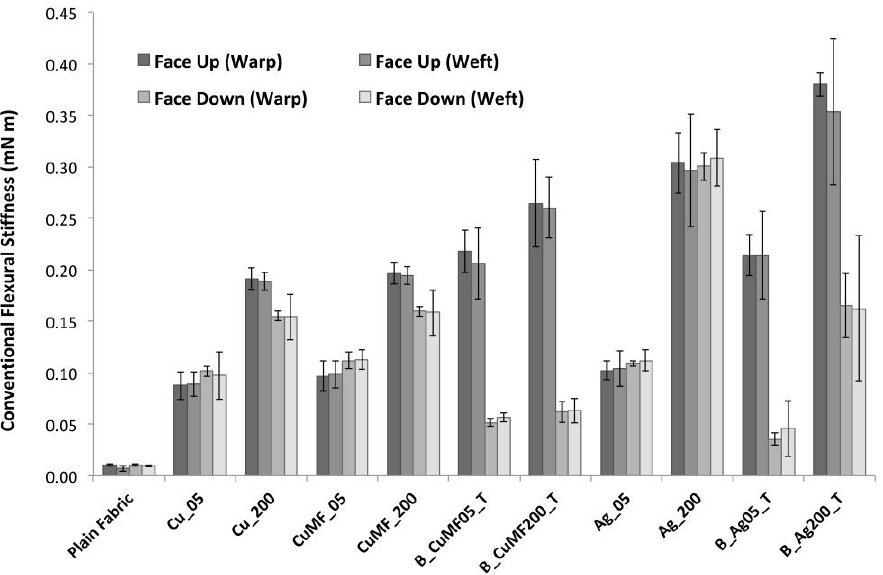
Figure 6. Conventional flexural sti ff ness of plain and coated fabrics with the lowest and highest amount of deposited solids (received from gap heights of 5 and 200 m) in the warp and weft direction and whether the sample is in the face up or down orientation. Individual standard deviations were used to calculate the intervals, and the plot displays a 95% CI for the mean.